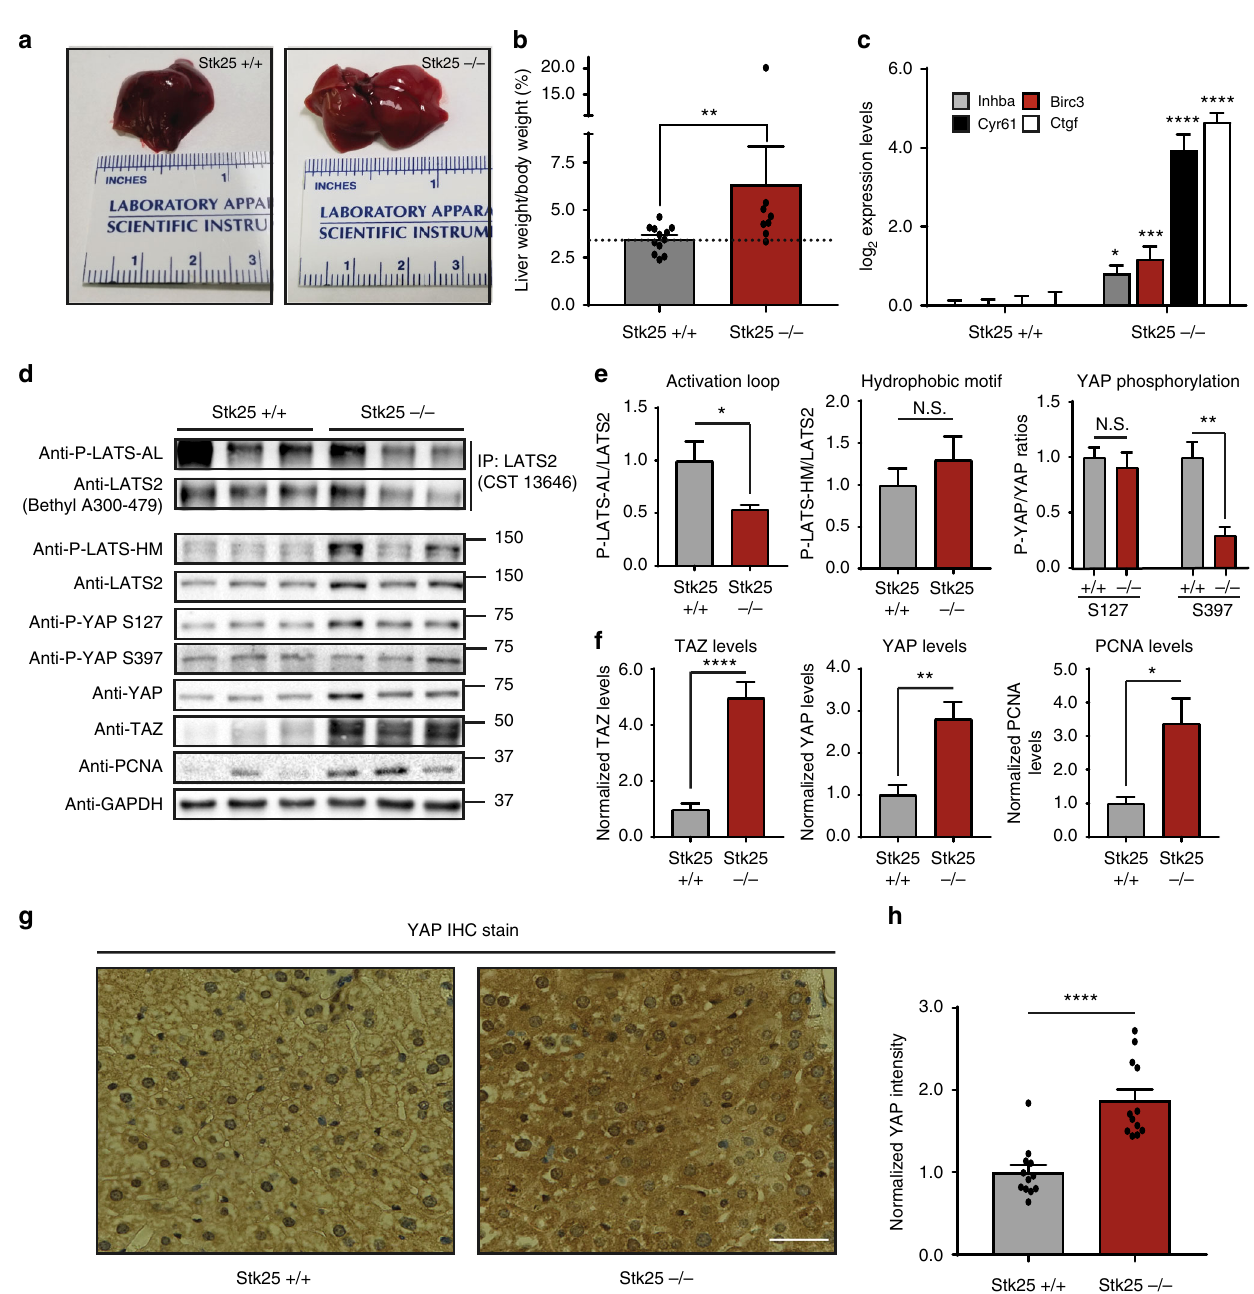
Fig. 6 Loss of STK25 inactivates Hippo signaling in vivo. a Representative photographic images demonstrating gross morphology and size of livers dissected from STK25 + / + or STK25 − / − mice. b Livers from STK25 + / + and STK25 − / − mice were dissected and weighed; liver/body weight ratios were then plotted for analysis ( n = 12 mice for STK25 + / + mice; n = 8 for STK25 − / − mice. ** p < 0.01, Mann – Whitney test). c qPCR analysis of validated YAP-target genes in the livers of STK25 + / + and STK25 − / − mice ( n = 3 biological replicates; * p < 0.05, *** p < 0.001, **** p < 0.0001, unpaired t -test). d Representative immunoblot of Hippo signaling components in the livers of STK25 + / + and STK25 − / − mice. To probe for P-LATS-AL, endogenous LATS2 was fi rst immunoprecipitated from tissue lysates and then re-analyzed via SDS – PAGE for phosphorylation status. e Quantitation of LATS phosphorylation and YAP phosphorylation in the livers of STK25 + / + and STK25 − / − mice from d ( n = 4 biological replicates, * p < 0.05, ** p < 0.01, N.S. indicates “ not signi fi cant, ” unpaired t -test). f Quantitation of total protein levels of interest in the livers of STK25 + / + and STK25 − / − mice ( n = at least four biological replicates, * p < 0.05, ** p < 0.01, **** p < 0.0001, unpaired t -test). g IHC staining for YAP was performed on sections of livers from STK25 + / + and STK25 − / − mice. Representative ×40 images are presented here. Scale bar, 100 µ m. h Quantitation of YAP staining intensity from g was performed and plotted for analysis ( n = 4 biological replicates, each with three randomly chosen fi elds of view for quantitation; **** p < 0.0001, Mann – Whitney test). All data